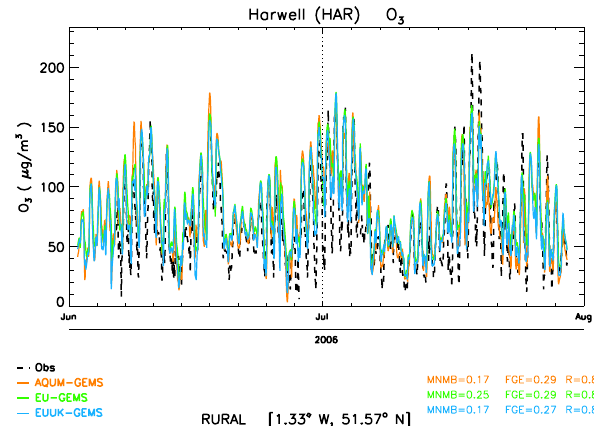
Fig. 13. Speciated PM 2 . 5 model forecasts for the rural site Harwell for the peak of the April 2011 episode.